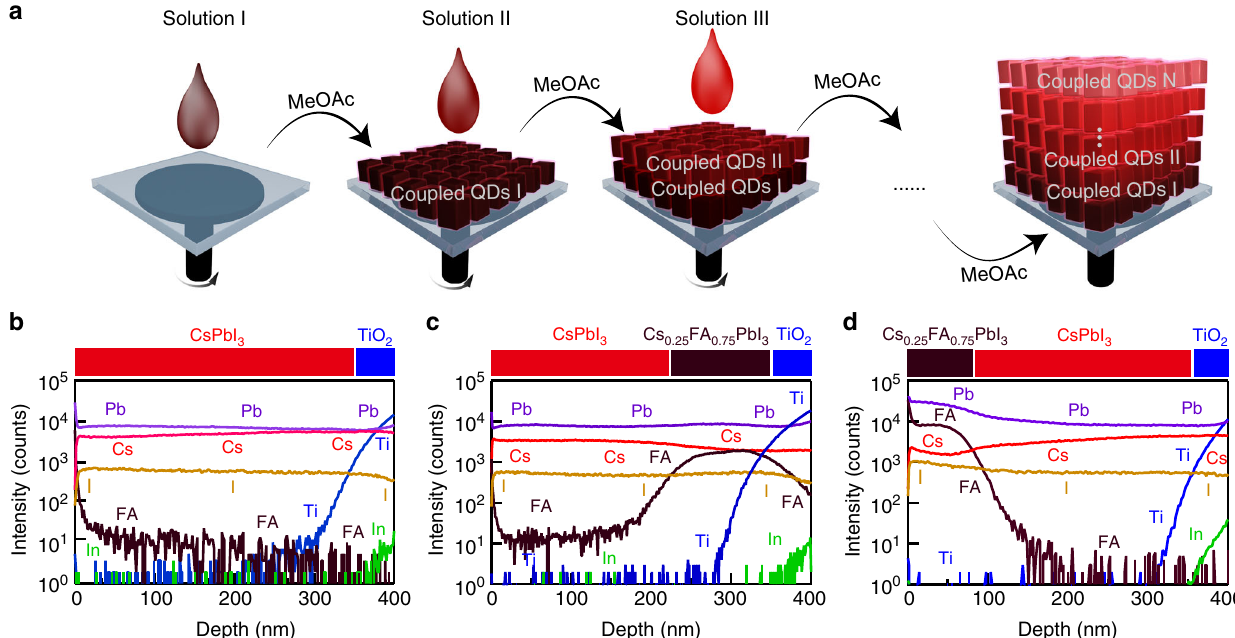
Fig. 1 Heterojunction structure of QD fi lms. a Schematic overview of layer-by-layer assembly showing a perovskite QD fi lm composed of different layers of QDs. MeOAc treatment is carried out between the deposition of different QD layers to remove the native oleate ligands and to render the deposited QDs insoluble in the solvent. b – d ToF-SIMS depth pro fi le of samples with the structure and interface location indicated in the bar above the plots of CsPbI 3 /TiO 2 ( b ), CsPbI 3 /Cs 0.25 FA 0.75 PbI 3 /TiO 2 ( c ), and Cs 0.25 FA 0.75 PbI 3 /CsPbI 3 /TiO 2 ( d ). All relevant elements from perovskite QD layer and TiO 2 are shown. Compared to the structure without Cs 0.25 FA 0.75 PbI 3 , the FA signal shows a sharp and signi fi cant change and the Cs signal also shows a slight change at the boundary between the CsPbI 3 and Cs 0.25 FA 0.75 PbI 3 QD layers. The In signal is shown as a reference for when the ToF-SIMS pro fi ling beam reaches the